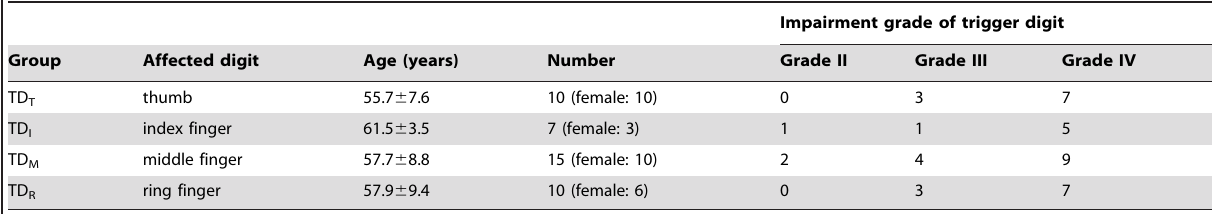
Table 1. Basic data of each TD group sorted by involved